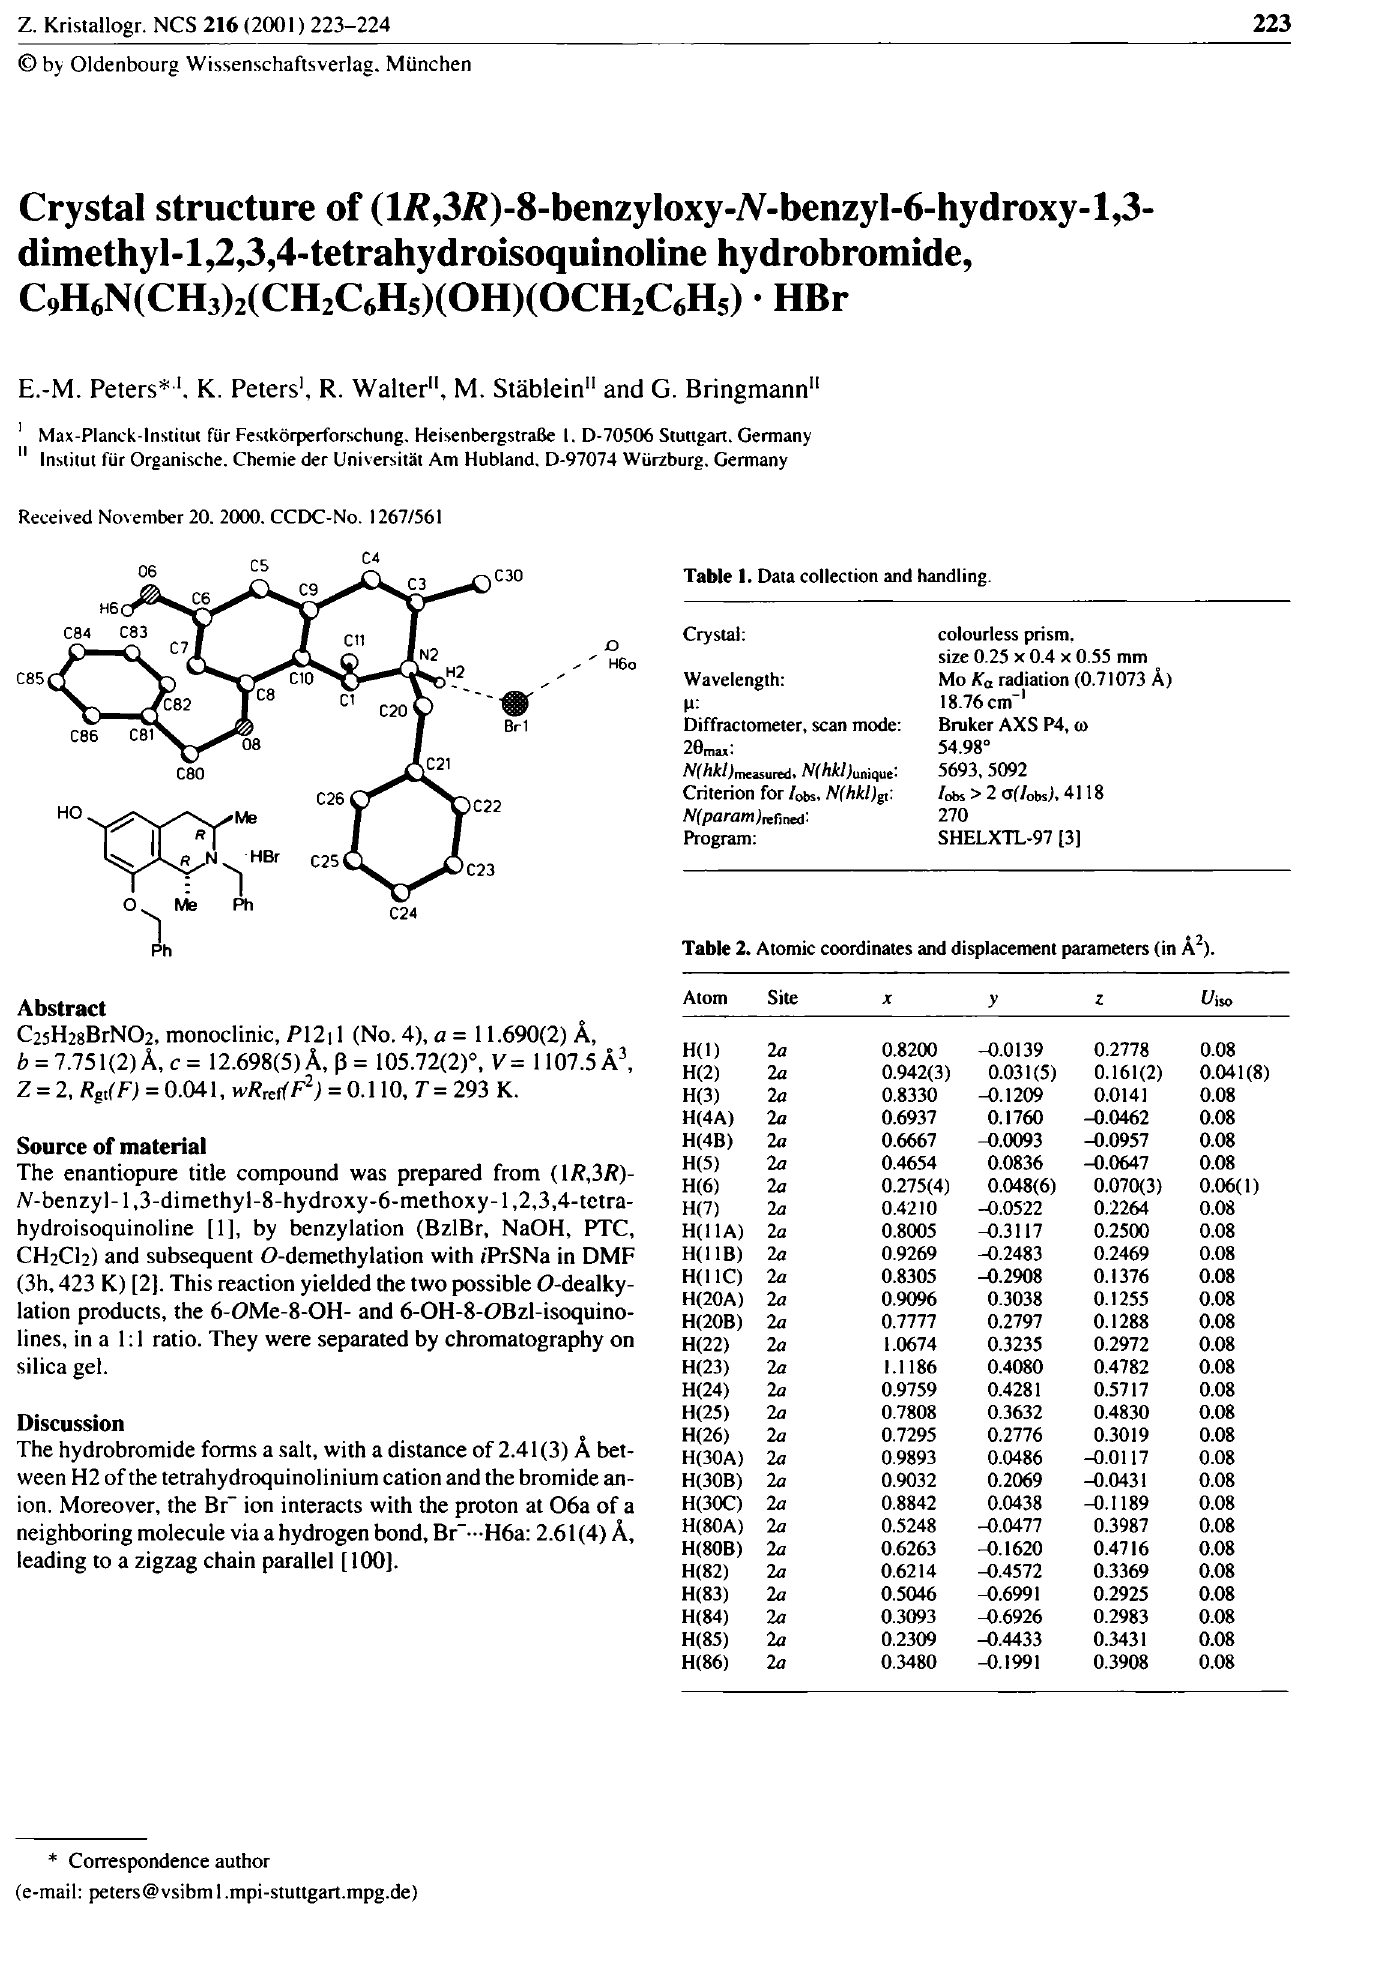
Table 1. Data collection and handling.